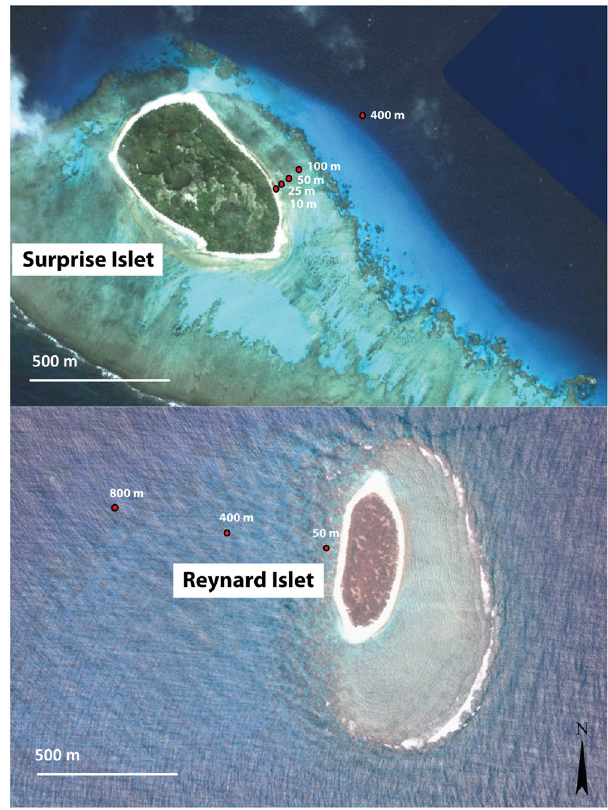
Figure 2. Geographic location of coral and nutrient sampling stations for Surprise and Reynard islets. The satellite images for the map were obtained from Government of New Caledonia (via the opensource portal https://explorateur-carto.georep.nc), and site locations were overlaid in Adobe Illustrator CS3 (version 13, www.